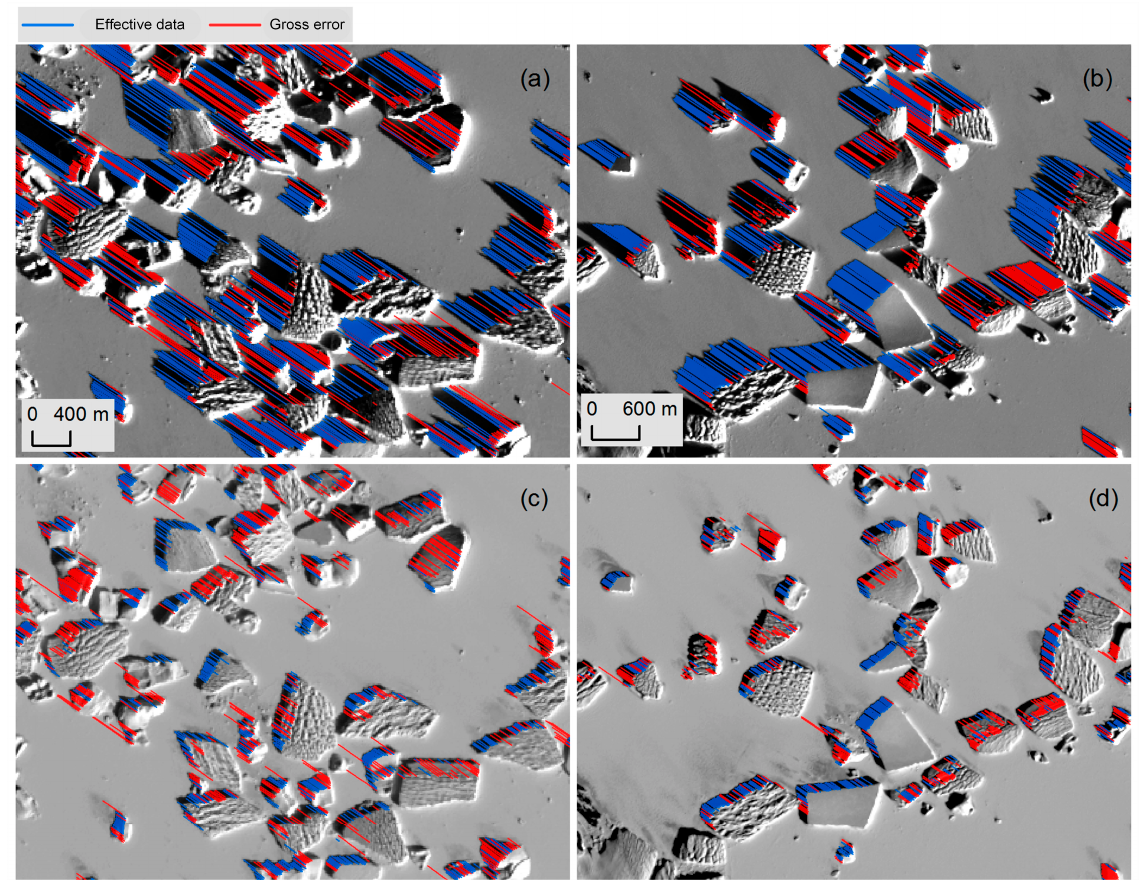
Figure 4. Gross error filtering of H 9/30 –H 8/29 . Distribution of the effective shadow vectors (blue lines) and the bad shadow vectors (red lines) overlaid on the images taken on ( a – b ) 29 August 2016, and ( c – d ) 30 September 2016.